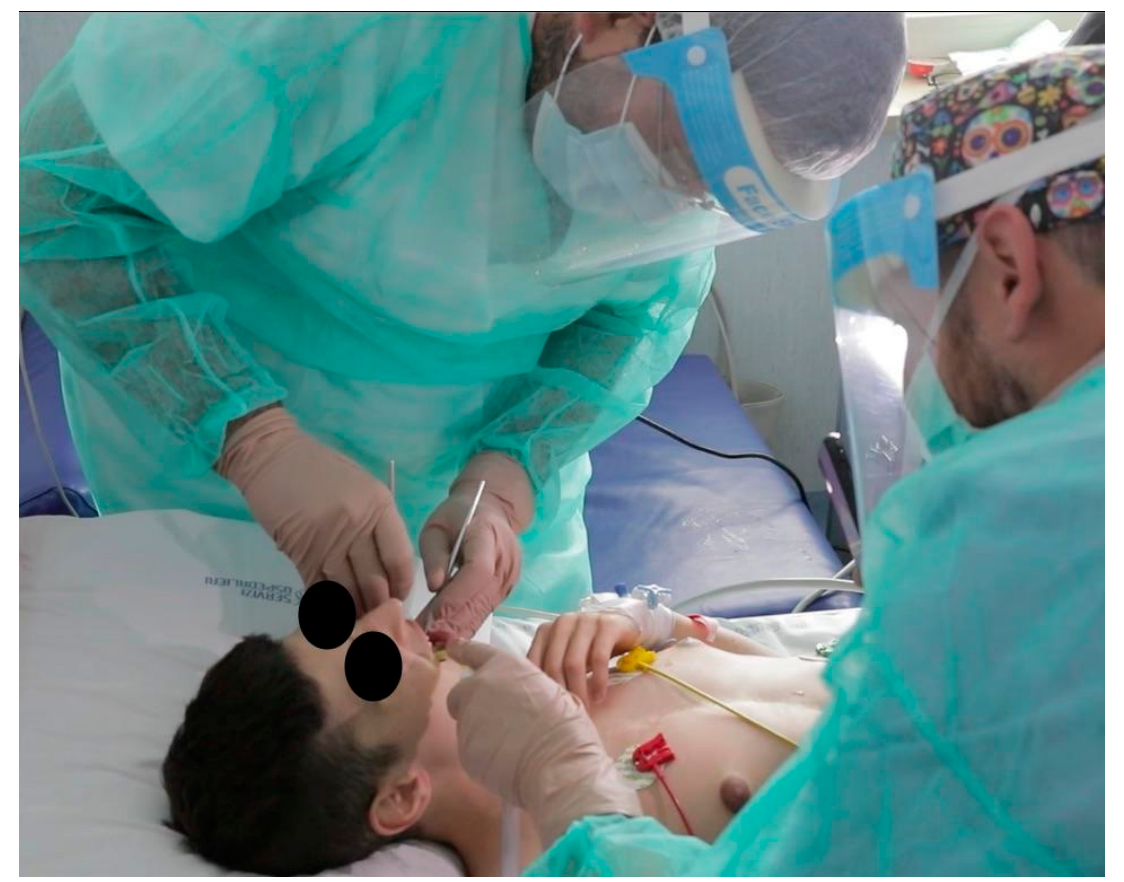
Int. J. Environ. Res. Public Health 2021 , 18 , x